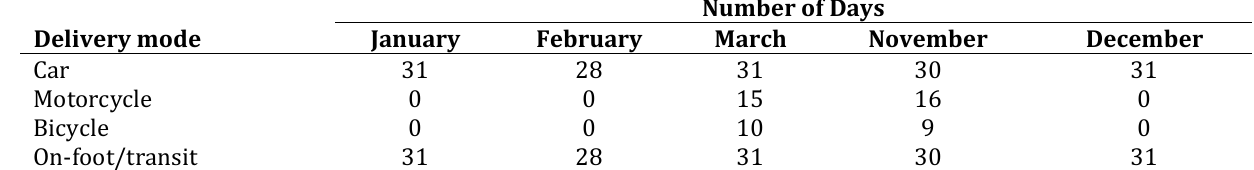
Table 4: Average number of working days for season with difficult weather conditions Delivery